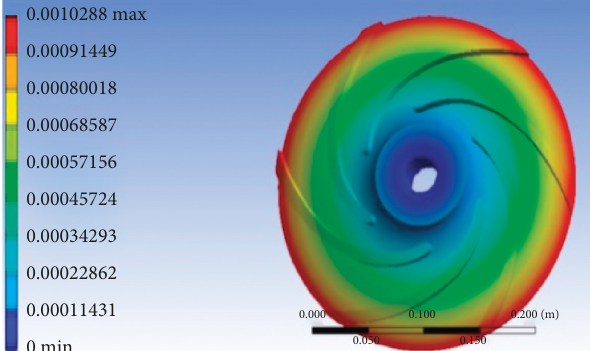
Figure 15: Total displacement and deformation after optimization.